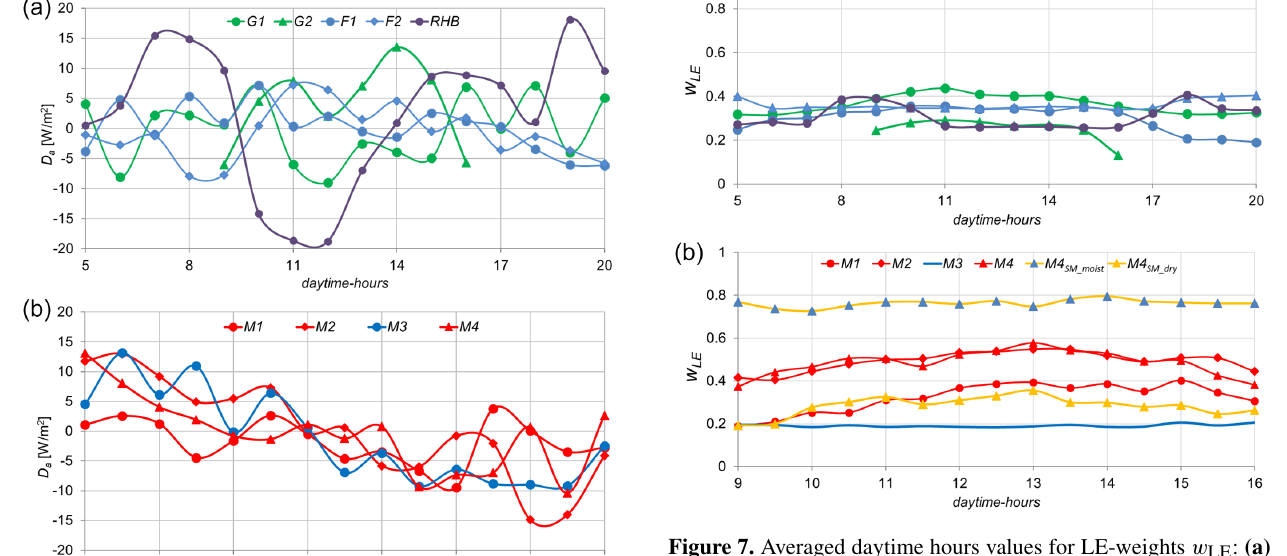
Figure 7. Averaged daytime hours values for LE-weights w LE : (a) as a function of daytime hours, humid; and (b) as a function of daytime hours, Majadas red: dry; blue: rainy season. M4 is split into the period “high soil moisture” (20 April to 23 June, yellow line, blue triangles) and “low soil moisture” (1 July and 4 September, yellow line, yellow